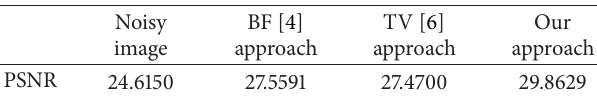
Table 1: Quantitative comparison of image denoising between our approach and previous approaches using